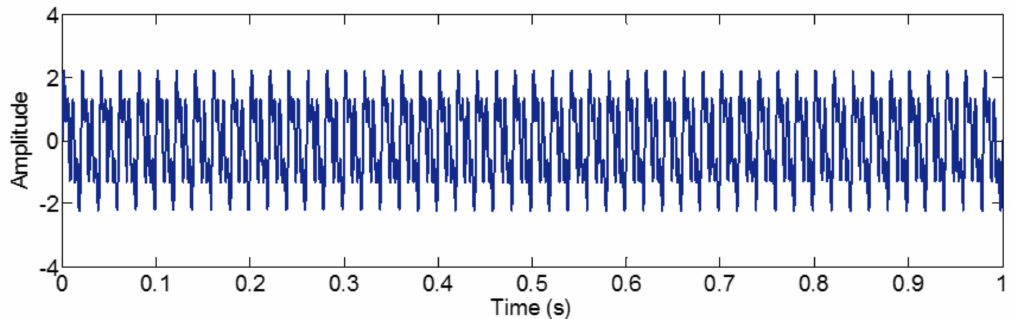
Figure 16. The waveform of the sample signal f sig 3